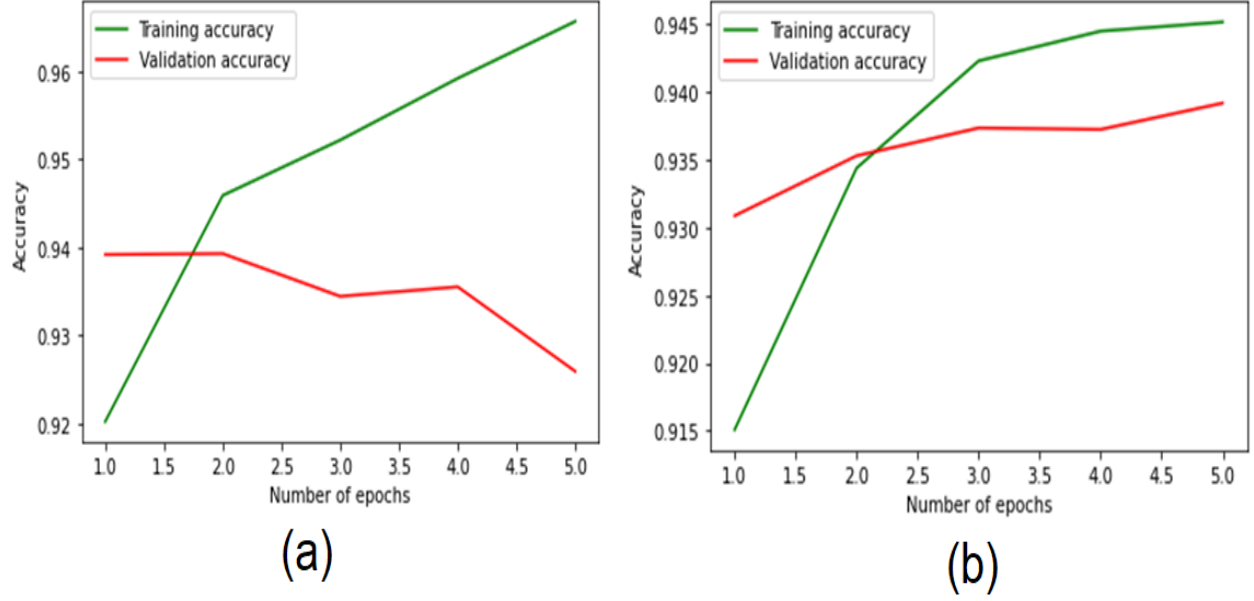
Figure 7. Performance plots of ( a ) CNN-BiLSTM and ( b ) BiLSTM using the binary class dataset. The accuracy losses of the two models are presented in Figure 8. Both models had difference losses scores, and the BiLSTM had lower loss compared to the CNN-BiLSTM.